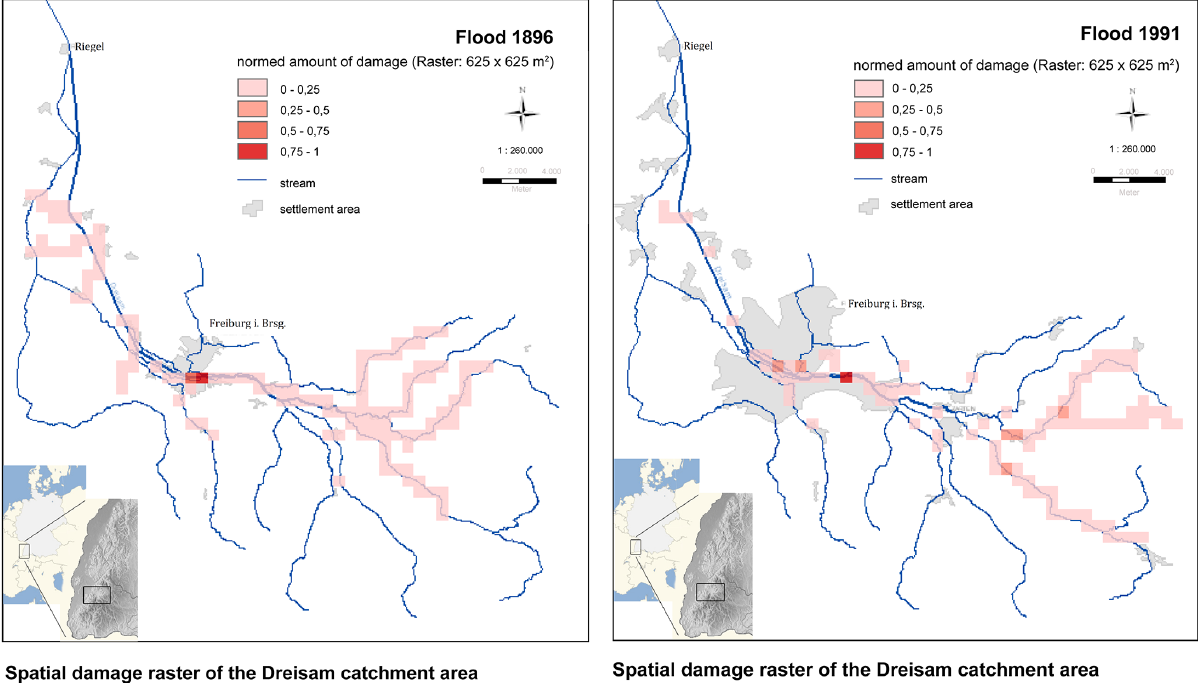
Figure 14. Normed damages of the floods from March 1896 (left) and December 1991 (right) near Freiburg.